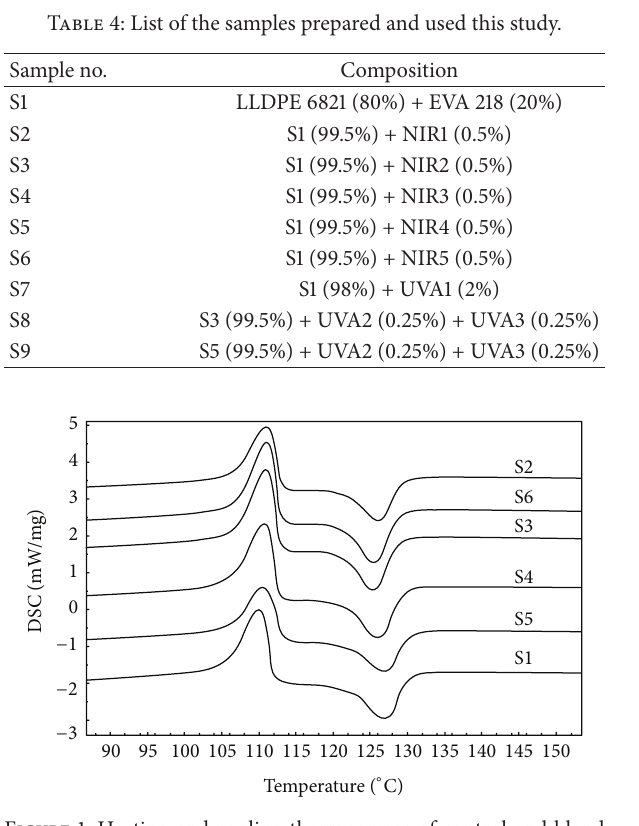
Figure 1: Heating and cooling thermograms of control and blend samples with NIR-reflective pigments.